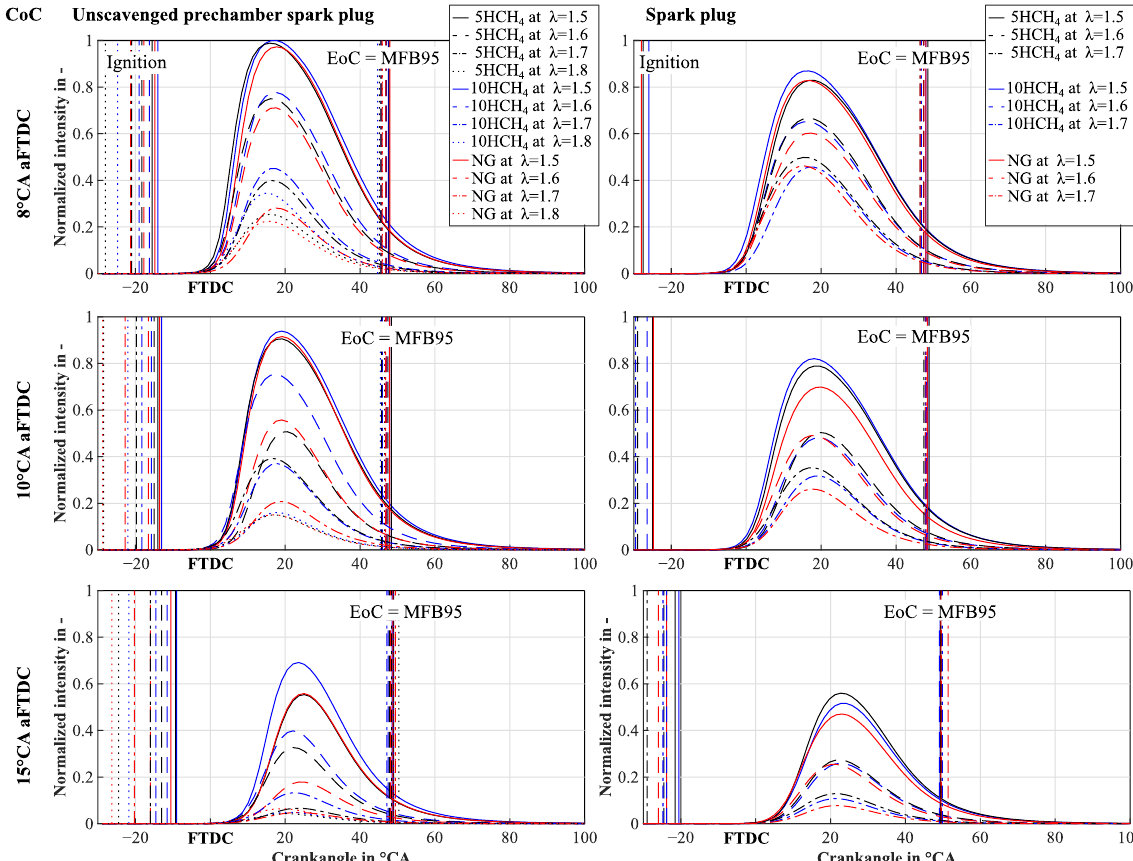
Figure 12. Intensity trace of the natural chemiluminescence for a CoC and air – fuel equivalence ratio variation comparing an unscavenged pre-chamber sparkplug to a spark plug.